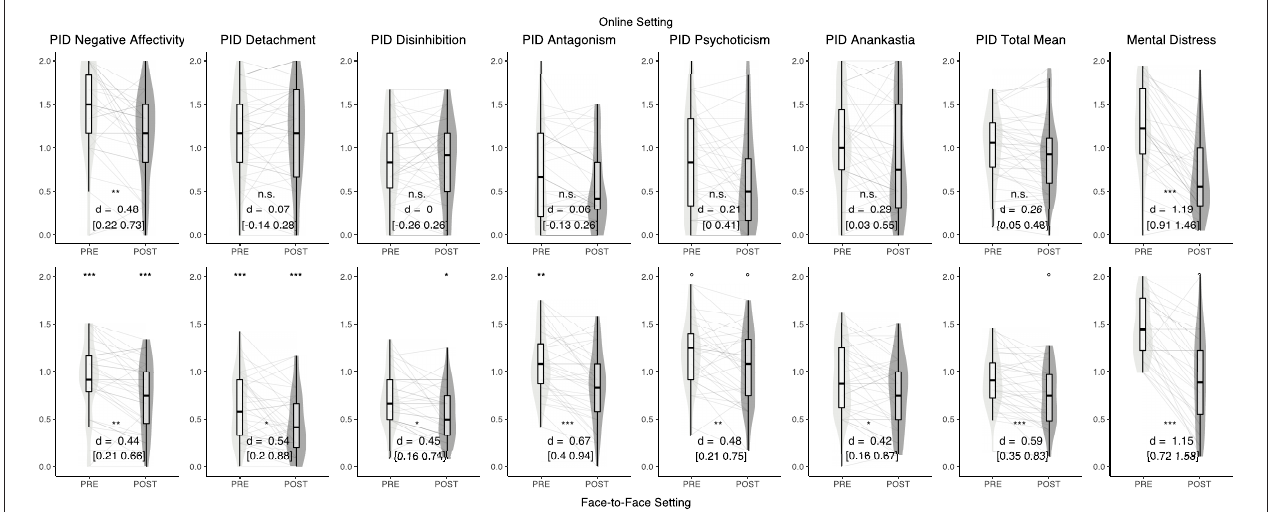
FIGURE 1 | Combined violin- and boxplots depicting distribution, median and standard deviations of maladaptive personality traits and mental distress. Gray lines are individual data. The upper row depicts data from the online mental health treatment condition, the lower row depicts data from the face-to-face/blended. Signs between the upper and lower row indicate significance of between-treatment differences, signs between boxplots represent within-treatment pre-post differences. ◦ uncorrected p < 0.05, *Bonferroni corrected p < 0.05, **Bonferroni corrected p < 0.01, ***Bonferroni corrected p < 0.001.